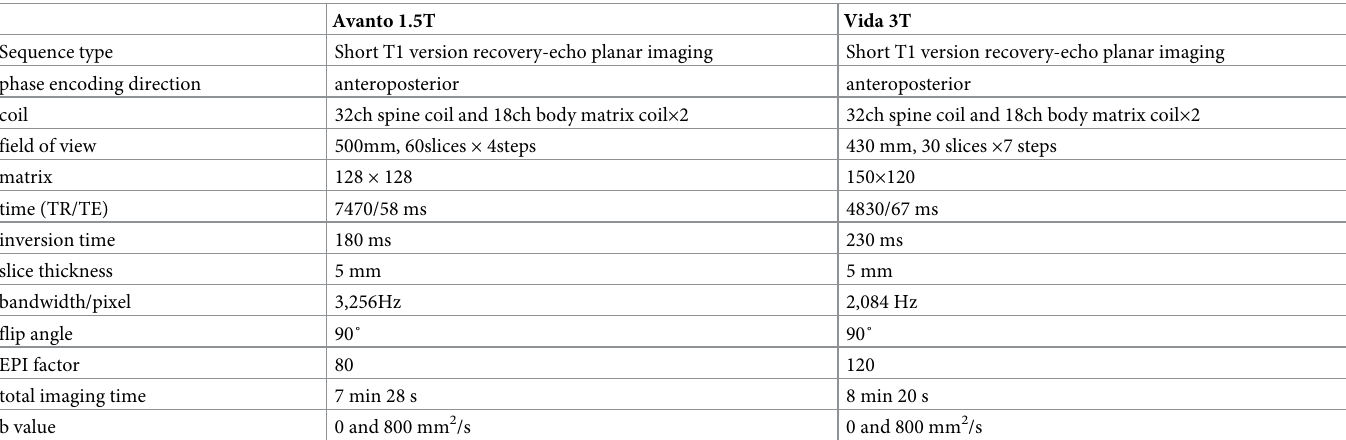
Table 4. Imaging protocols for the DWIBS experiments.